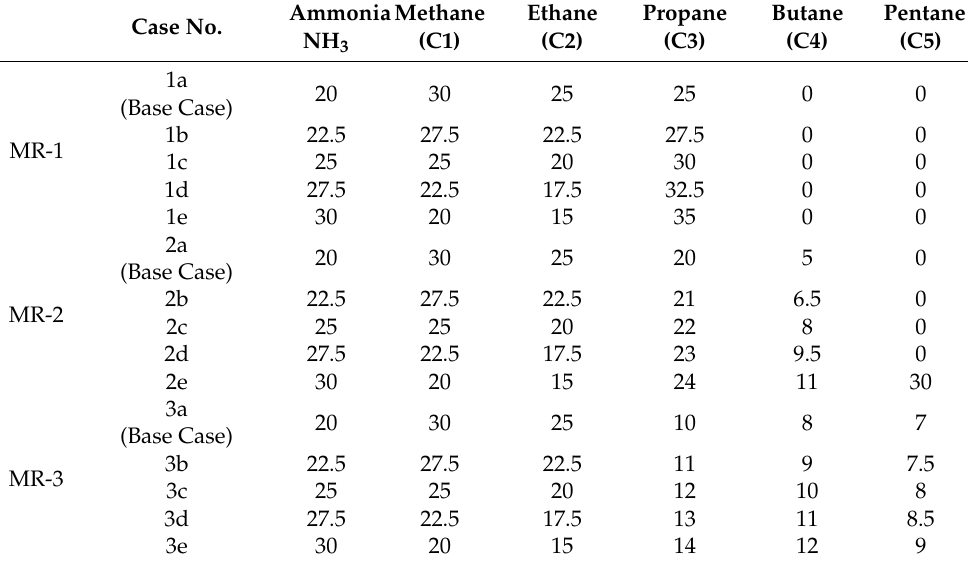
Table 3. Molar compositions of mixed refrigerant for each case study. Case